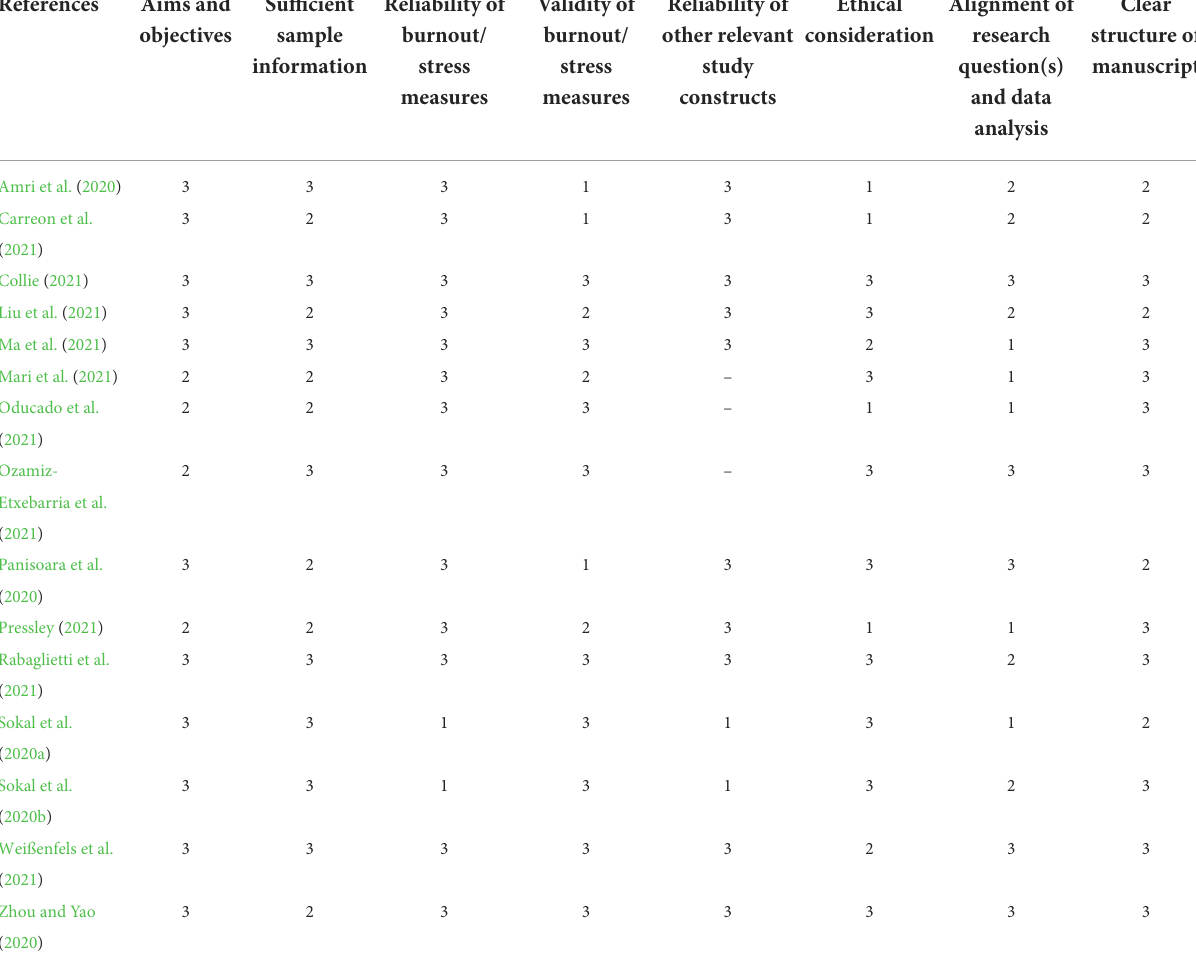
TABLE 3 Quality ratings of non-intervention studies included in the